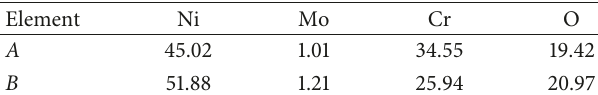
Table 2: Chemical compositions of the inner oxide layer and the outer layer after immersion for